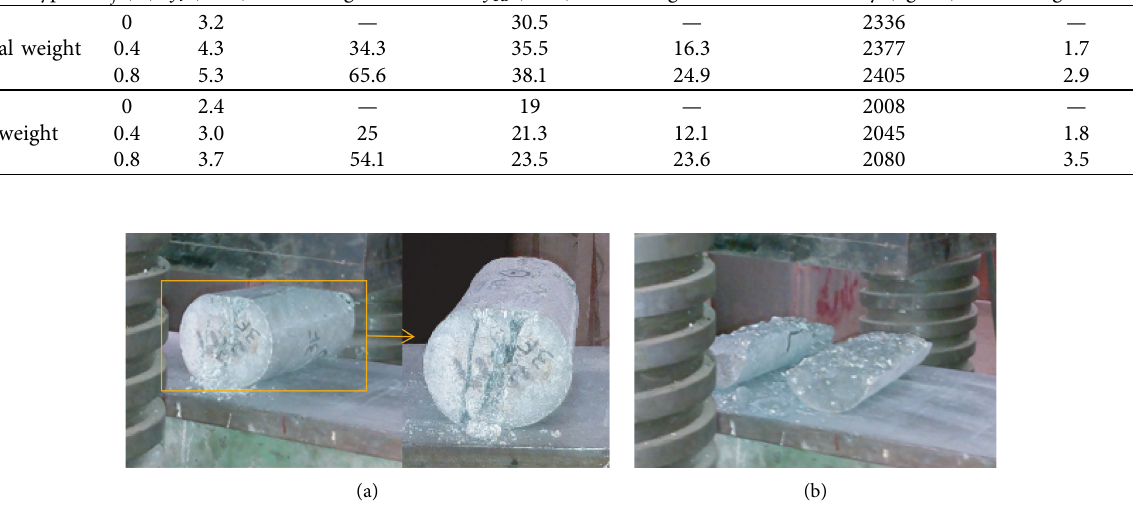
Figure 6: Failure of lightweight cylinders after splitting tensile test (a) with and (b) without steel fiber. Table 9: Effect of replacing normal-weight aggregate by lightweight aggregate on the splitting-tensile strength, compressive strength, and density with various ( V f ) values.